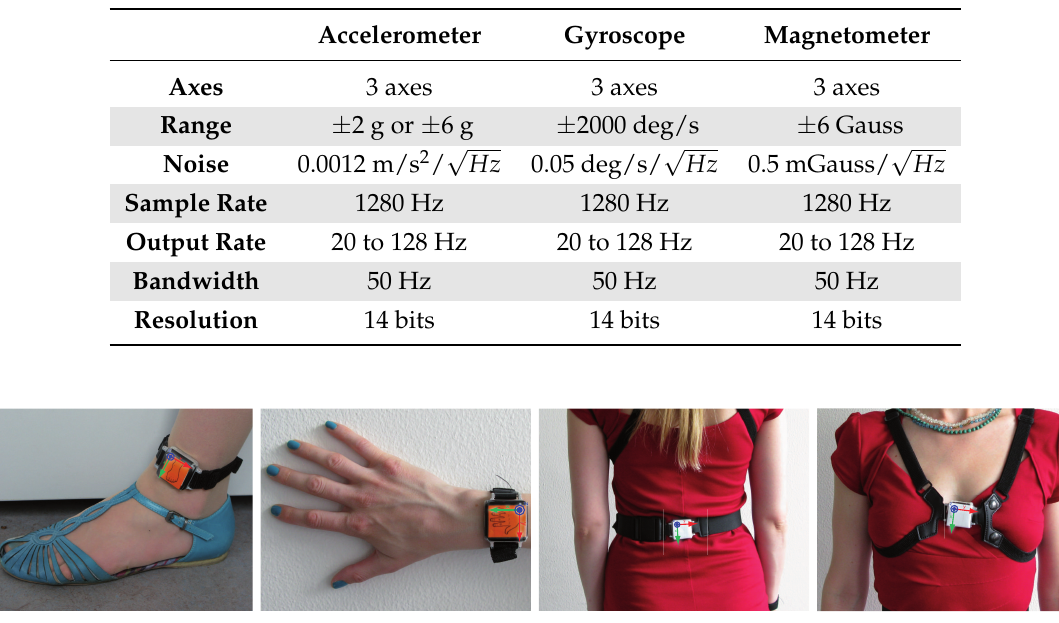
Figure 1. Placement of four APDM Opal IMUs on different body parts. The sensors were placed on four different locations: left ankle, right wrist, lower back and